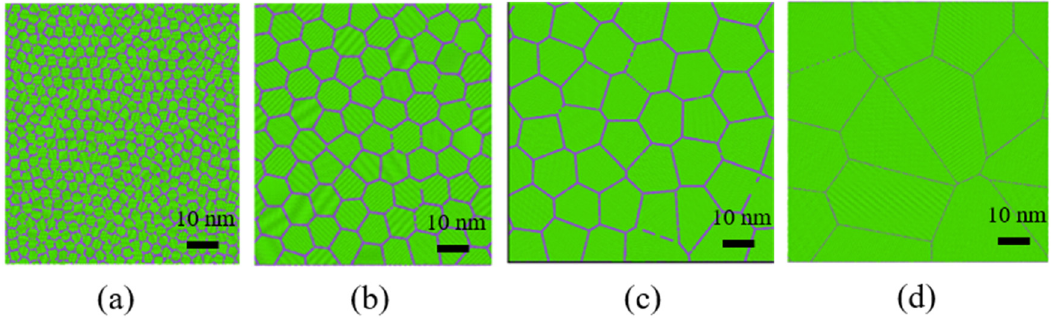
Figure 2: MD samples of the nanocrystalline copper with grain size of ( a ) 3 nm, ( b ) 12 nm, ( c ) 20 nm, and ( d ) 50 nm.